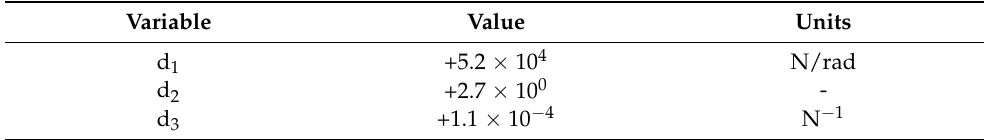
Table 3. Values obtained by means of a least squares fitting of Equation